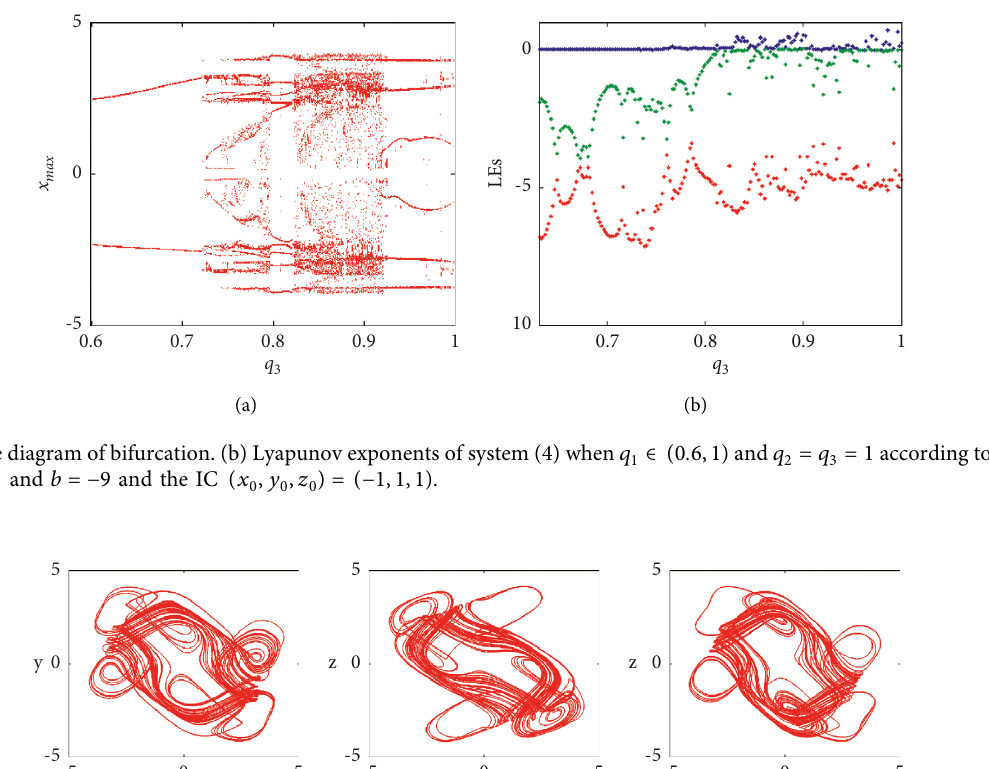
, y ,z ) � (− 1 , 1 , 1 ) . 0 0 0